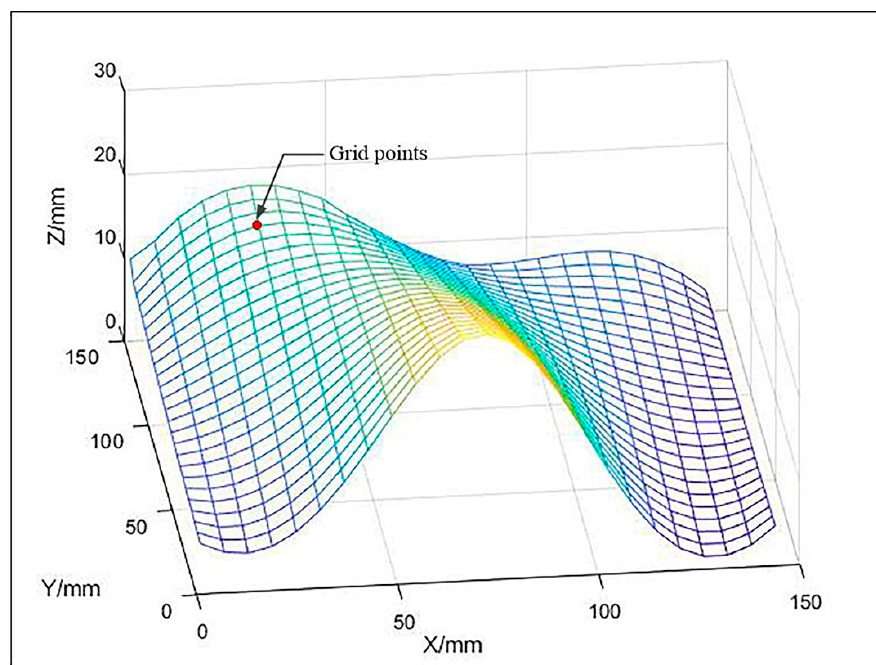
Figure 1. Mesh Surface and Grid points.